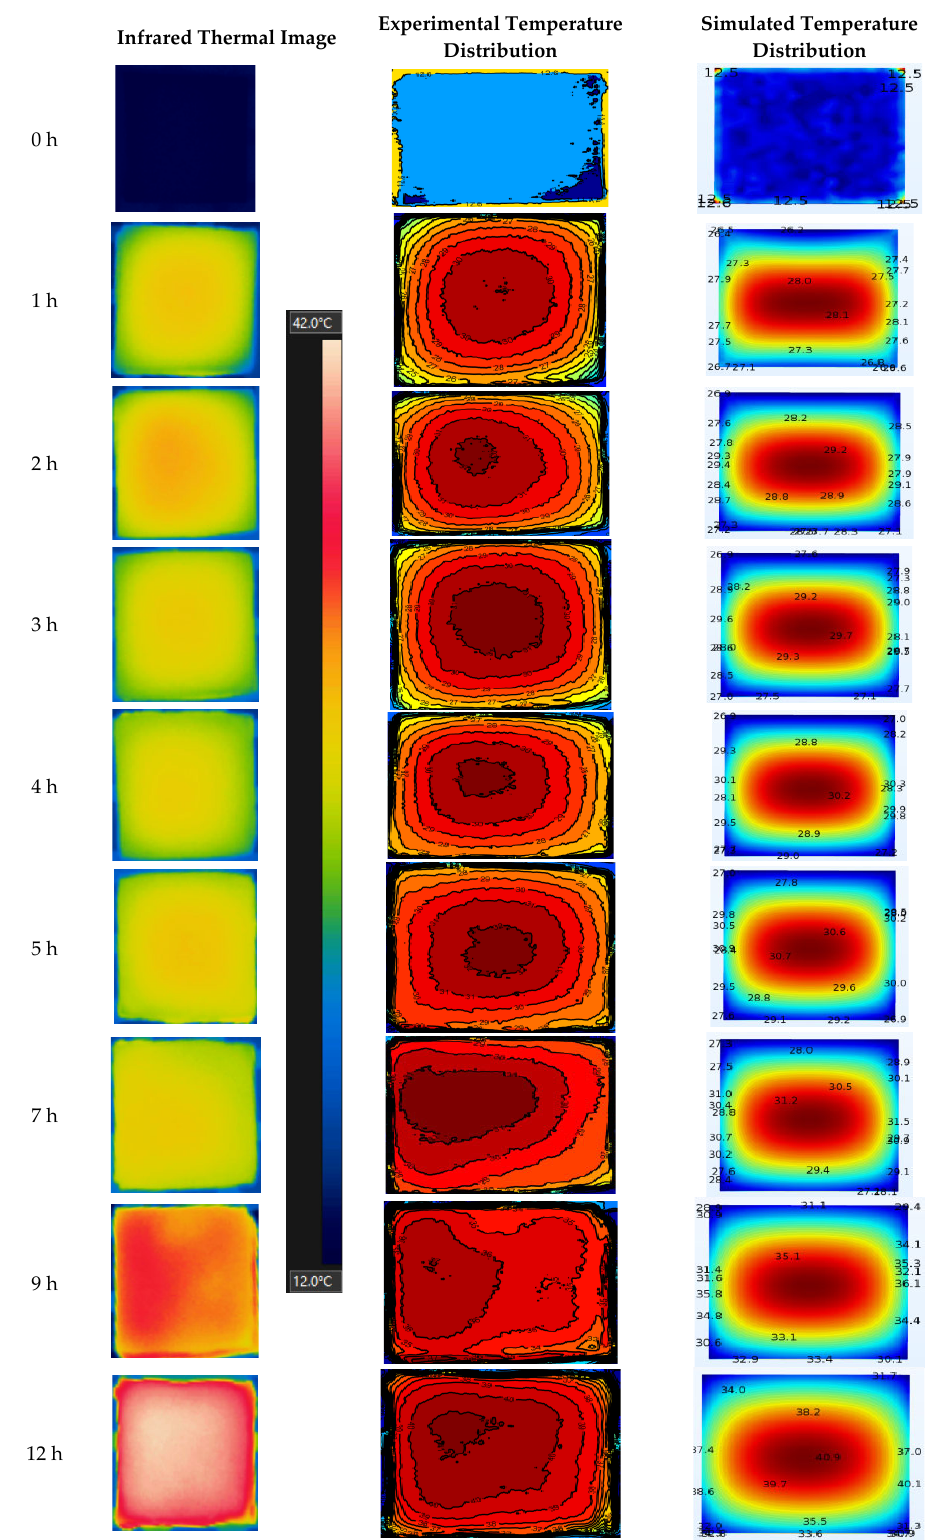
Figure 4. Experiment and simulated temperature profiles of potatoes after RF drying.